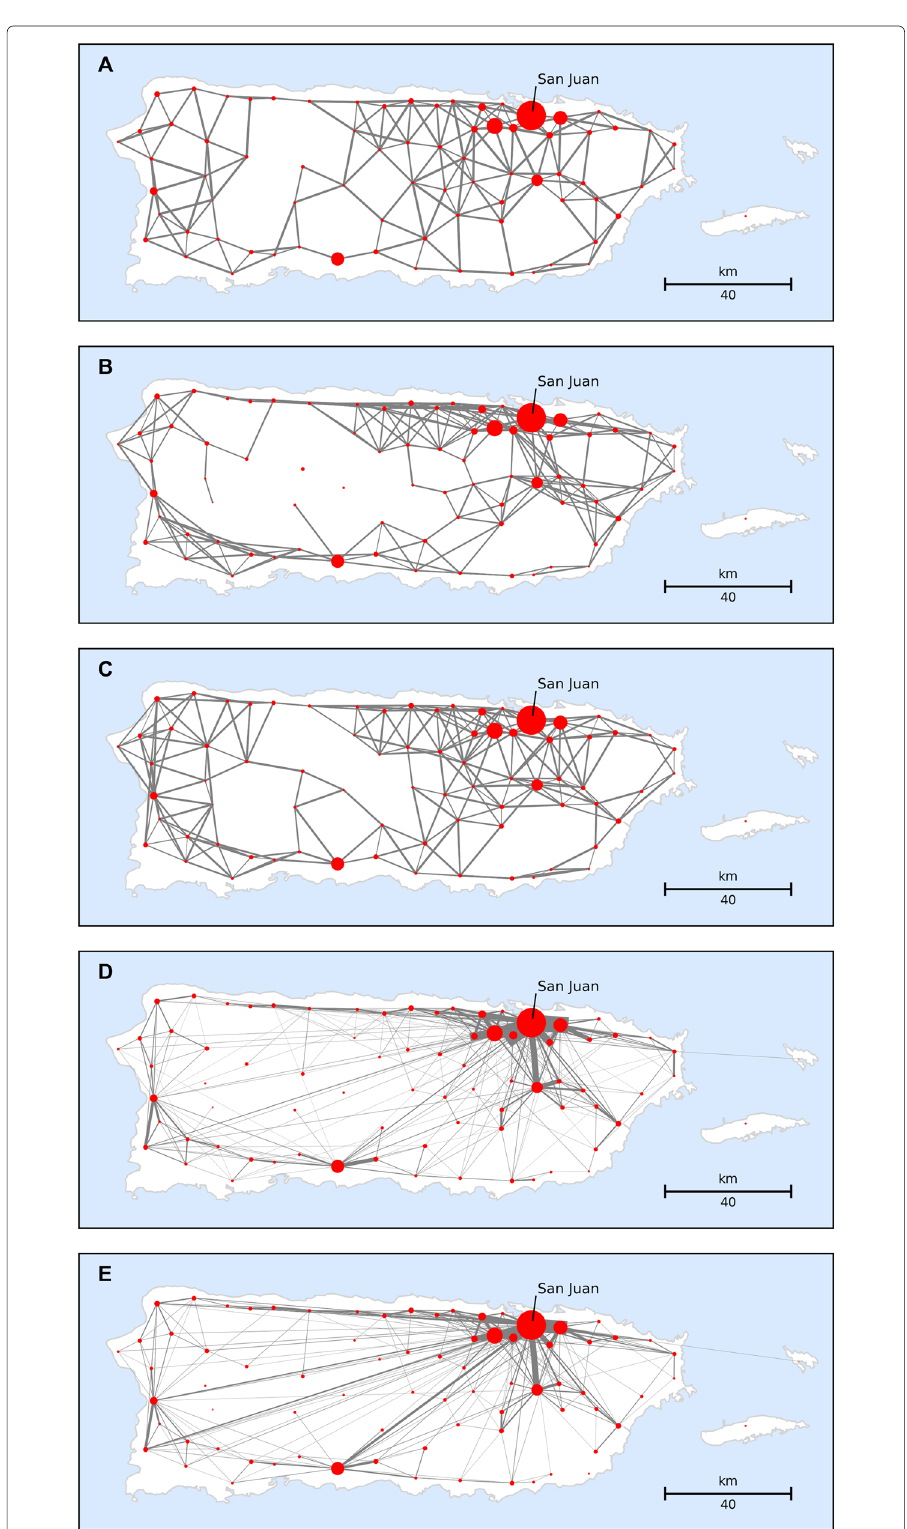
Fig. 5 Visualization of distance weights of each network